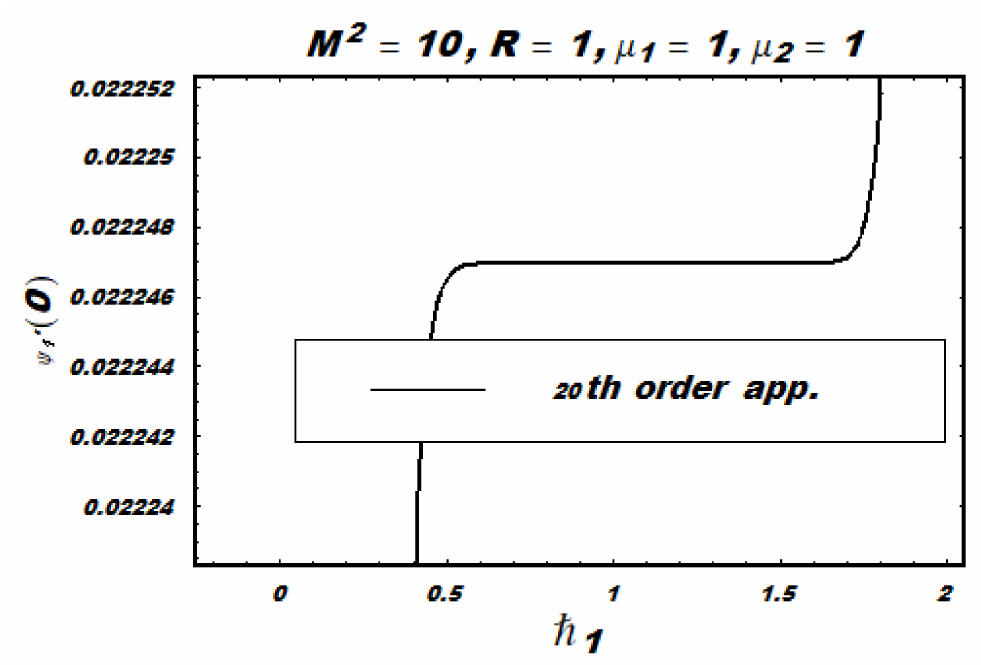
Figure 2. (cid:125) 1 for the strip / long